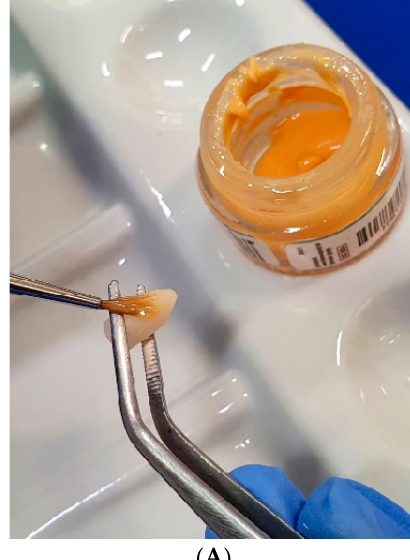
Figure 2. ( A ) Staining; ( B ) glazing.